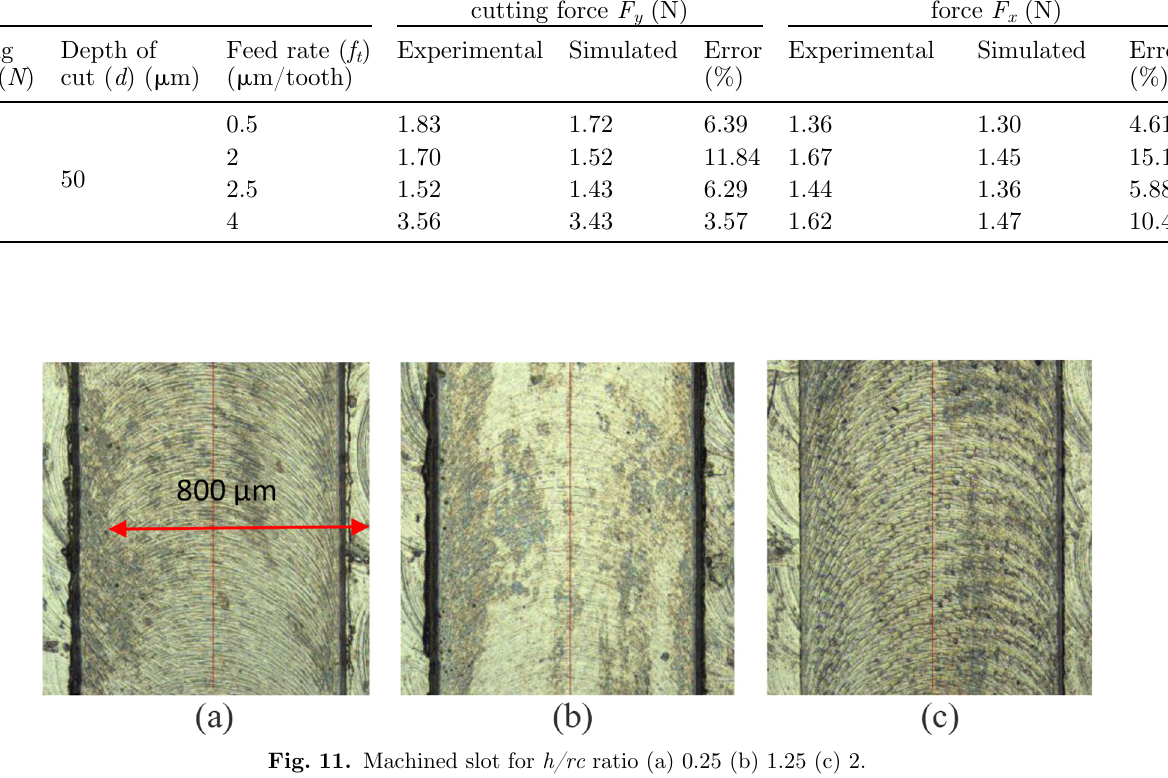
Table 5. Experimental and simulated cutting force value. Cutting condition